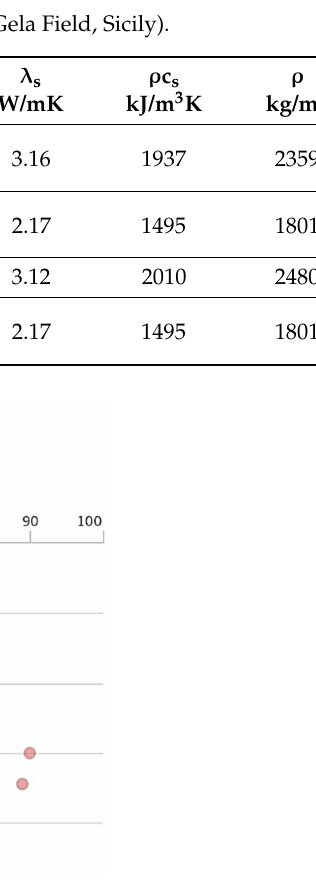
Figure 4. Temperature data visualisation for the Gela 38 hydrocarbon well: Depth (m); Temperature ( ◦